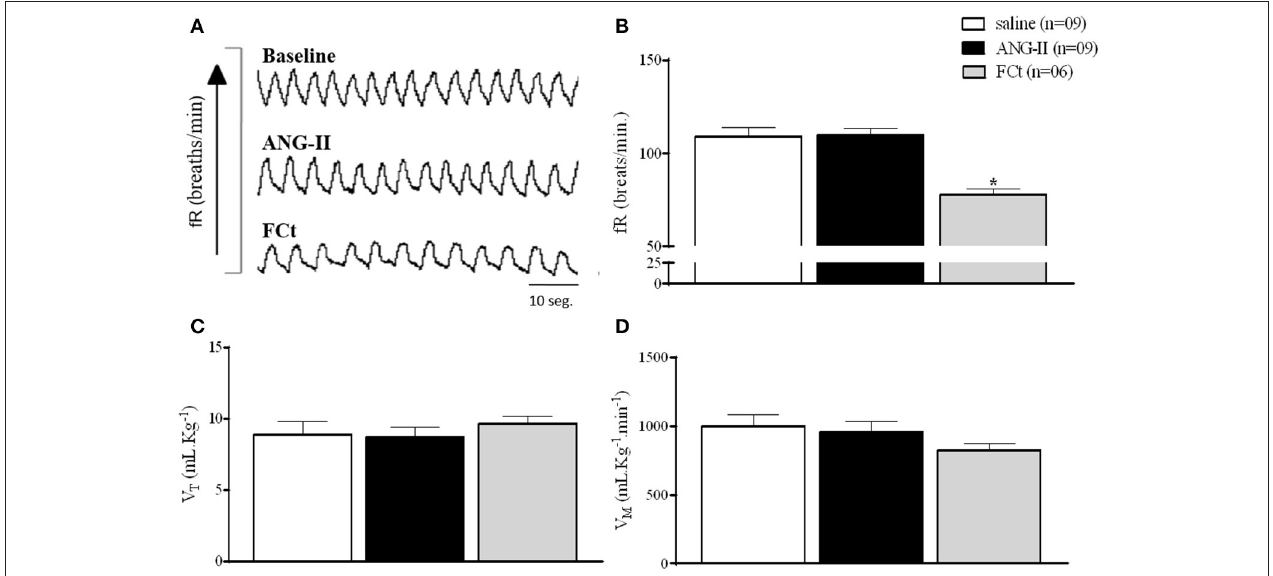
FIGURE 5 | Effect of icv ANG-II or FCt microinjection on baseline respiratory parameters. (A) Representative tracings of one rat showing the baseline and changes in the fR (breaths/min) induced by icv microinjection of ANG-II and FCt. Arrows indicate icv ANG-II or FCt microinjections. (B–D) Respiratory frequency [fR, breaths/min (B) ]; Tidal Volume [V T mL.Kg − 1 (C) ] and Volume Minute [V M mL.Kg-1.min − 1 (D) ] after microinjection icv of saline, ANG-II, or FCt. One-Way ANOVA followed by the Newman–Keuls post test. Values were expressed as means ± SEM. * p < 0.05 vs. saline.